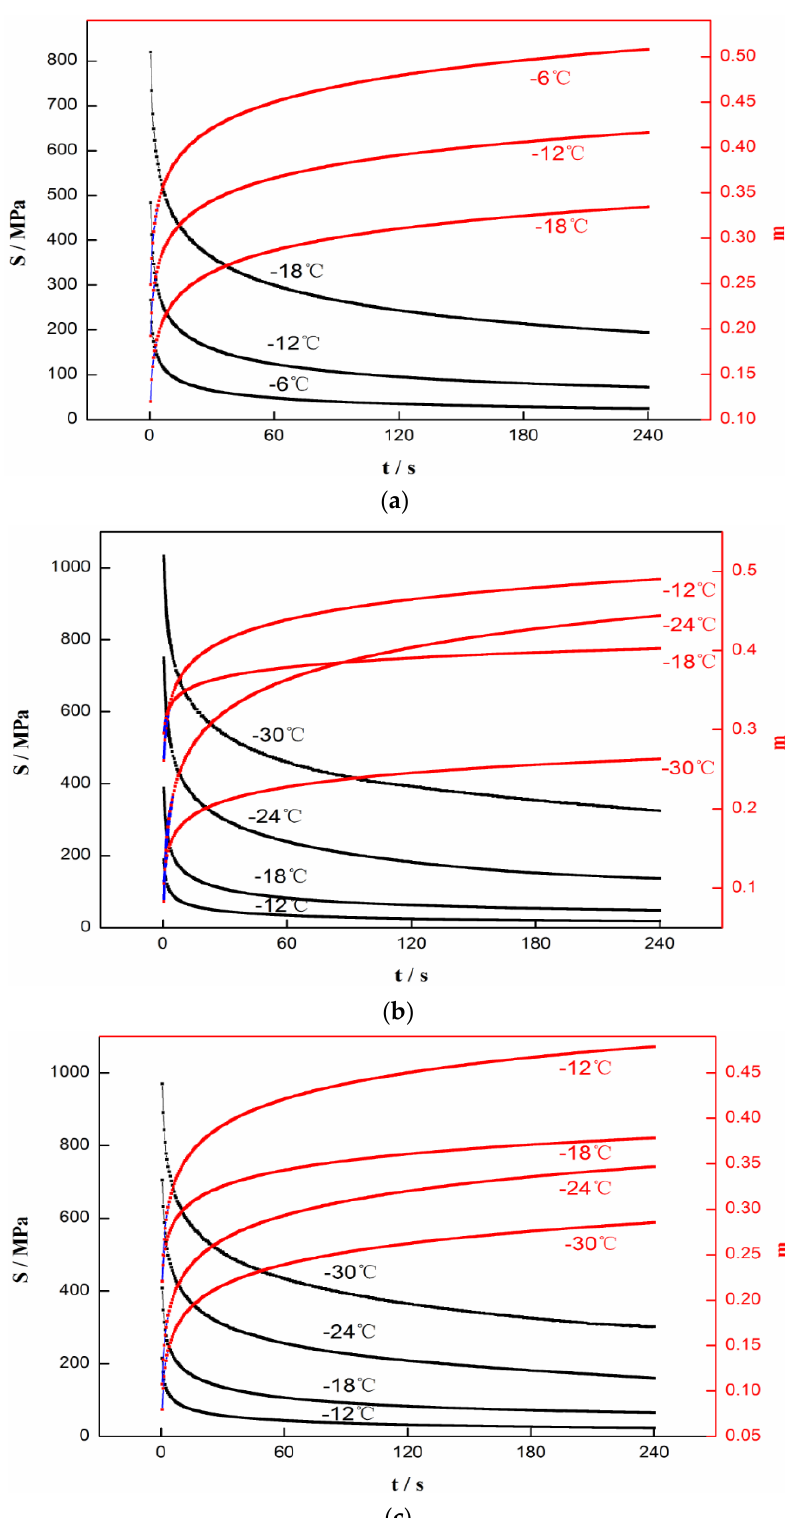
Figure 17. The variations of creep rate and stiffness modulus changing with time. ( a ) JZ, ( b ) AR, and